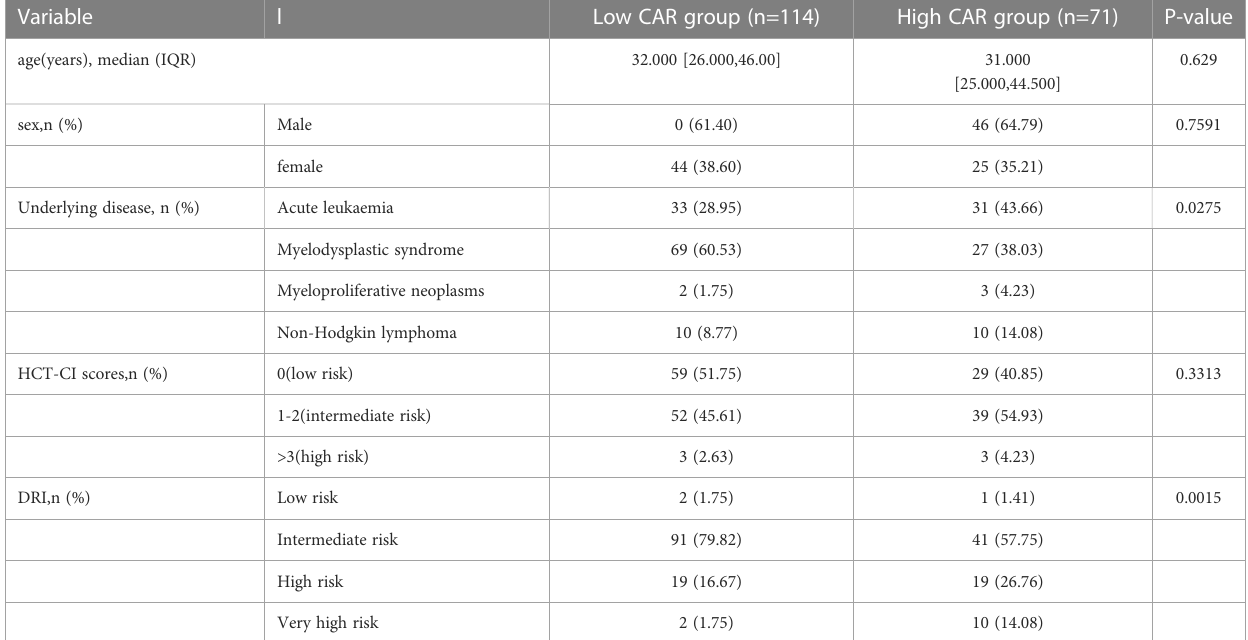
TABLE 1 The relationship between CAR and clinical